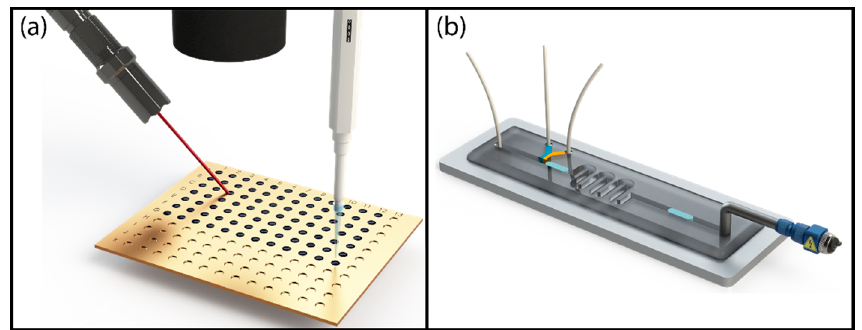
Figure 7. Schematic illustration of label-free mass spectroscopic detection techniques: ( a ) matrix-assisted laser desorption/ionization (MALDI) MS; ( b ) electrospray ionization (ESI) MS.